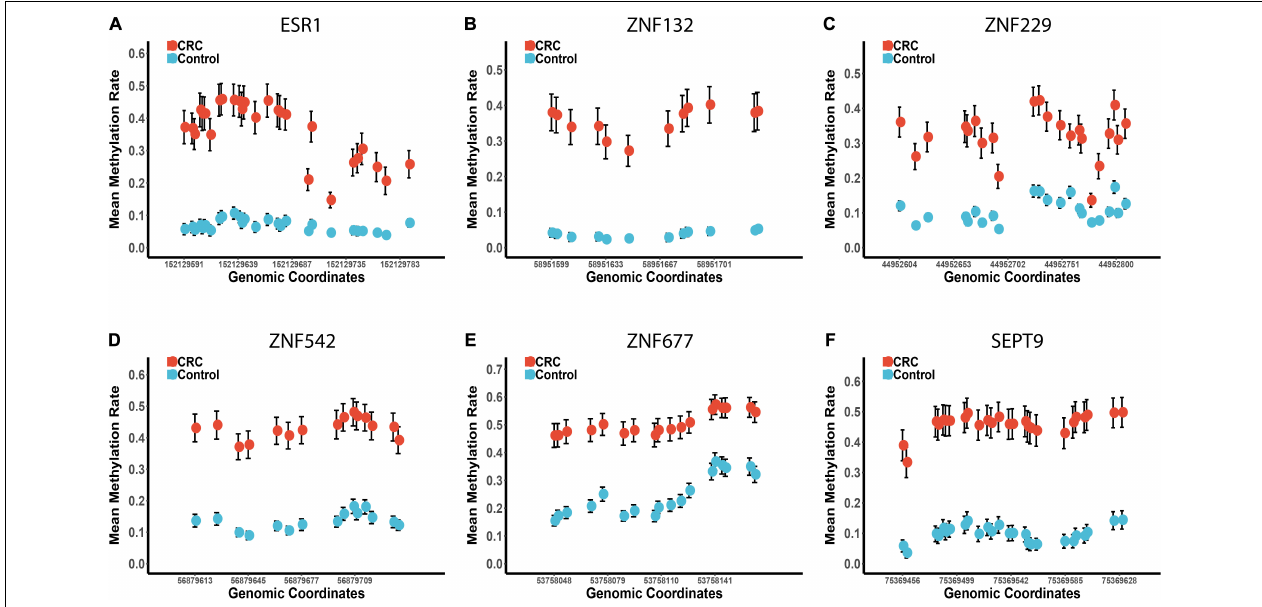
FIGURE 3 | The methylation profiles of the five zinc finger genes and SEPT9 in the replication cohort 1. Panels (A–F) represents the mean methylation status of the CpG sites in regions covering ESR1 , ZNF132 , ZNF229 , ZNF542 , ZNF677, and SEPT9 , respectively. The x-axis represents the genomic positions of the CpG sites in the targeted regions. The y-axis represents the mean methylation percentage in the CRC tumor tissues and paired normal tissues for each CpG site. The error bar of each CpG site represents the confidence interval of the methylation percentage.